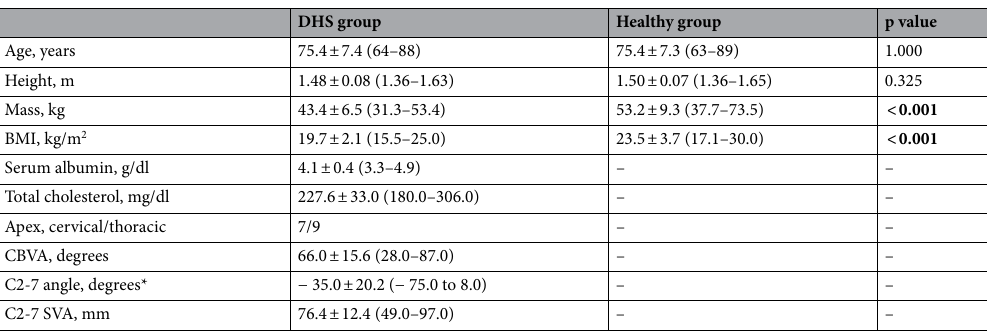
Table 1. Demographic data of the participants. Data are presented as the mean ± SD (range). Bold figures indicate statistical significance with p < 0.05. DHS dropped head syndrome; BMI body mass index; CBVA chin– brow vertical angle; SVA sagittal vertical axis. *Positive value indicates